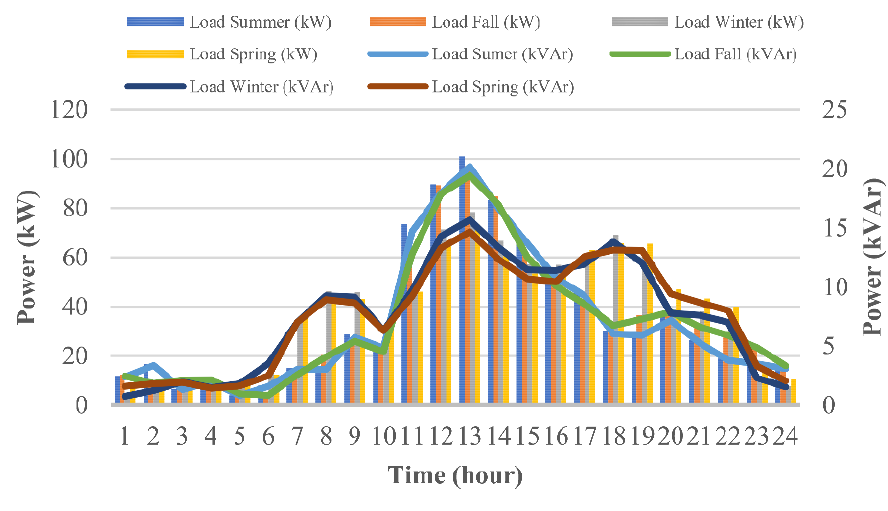
Figure 7. The daily load demand for 4 seasons.